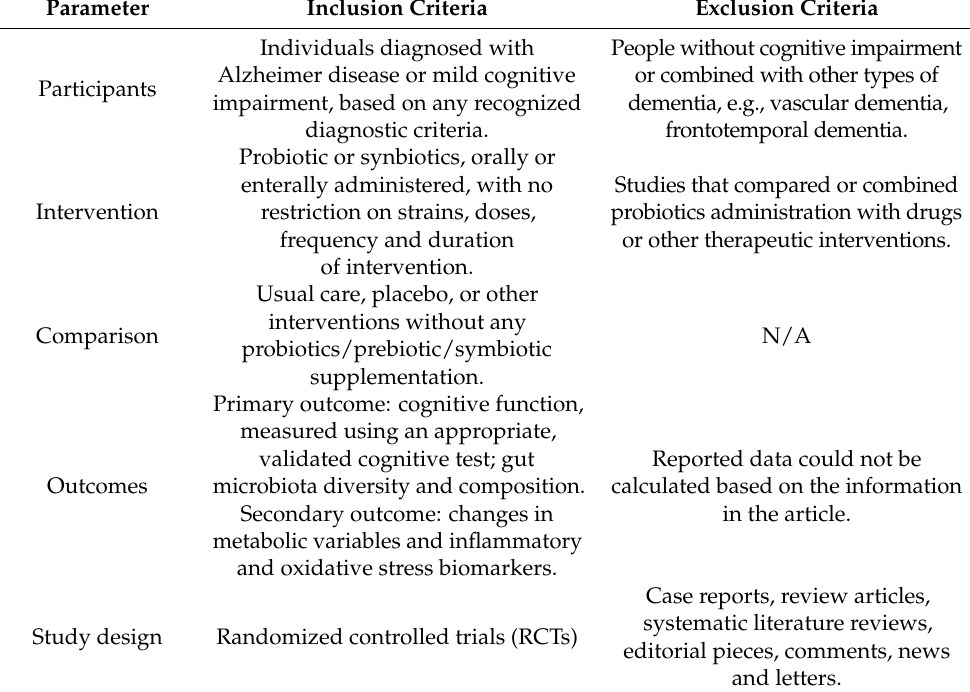
Table 1. The PICOS criteria for inclusion and exclusion of